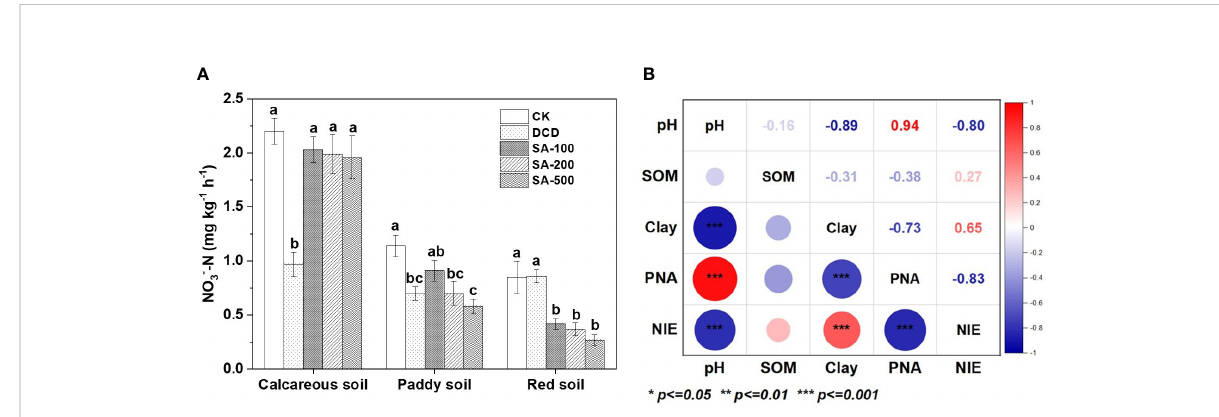
FIGURE 2 The potential nitri fi cation activity (PNA) affected by different treatments in three soils at the end of incubation (A) , and the Pearson correlation test between soil properties (pH, soil organic matter (SOM), and clay percentage), PNA, and nitri fi cation inhibitory ef fi cacy (NIE, %) (B) . Values are means ± SE (n=3). Different letters indicate signi fi cant differences at P < 0.05 (LSD test) among treatments at each soil type. The sizes of the circles and the shades of color represent the degree of relevance. The numbers are the correlation coef fi cients.